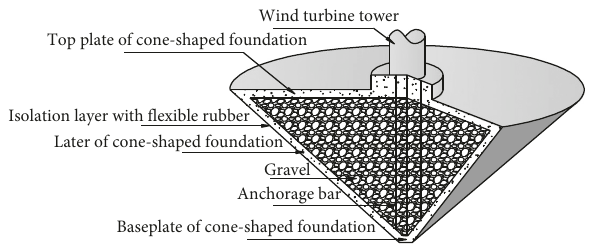
Figure 1: Cone-shaped